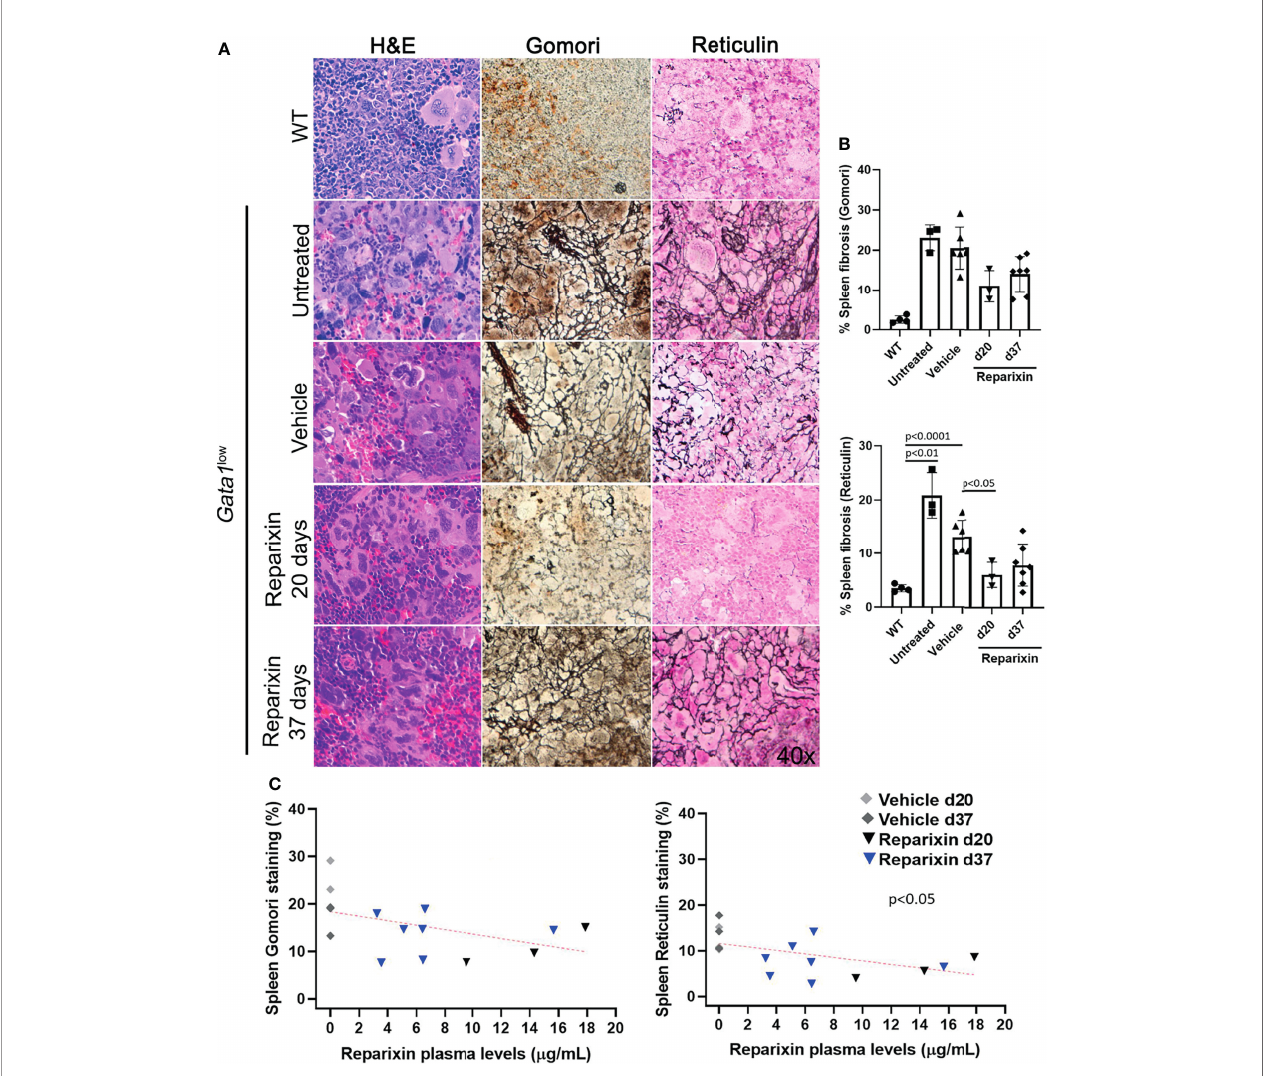
FIGURE 5 | Reparixin decreased in a concentration-dependent fashion the degree of fi brosis present in the spleen of Gata1 low mice. (A) H&E, Reticulin, Gomori and reticulin stainings of spleen sections from representative Gata1 low mice treated either with vehicle or Reparixin for 20 or 37 days, as indicated. Untreated Gata1 low and WT littermates are presented as positive and negative controls, respectively. Magni fi cation ×400. (B) Levels of fi brosis quanti fi ed by image analyses in spleen sections stained with Gomori or Reticulin from Gata1 low mice treated either with vehicle or Reparixin, as indicated. Data were presented as Mean (± SD) and were analyzed by Tukey ’ s multiple comparisons test. P < 0.05 was considered statistically signi fi cant. (C) Linear regression analyses of fi brosis and plasma levels of Reparixin in individual mice (Pearson R = − 0.48, not signi fi cant for Gomori staining; Pearson R = − 0.53, p < 0.05 for Reticulin staining). Each dot represents a single